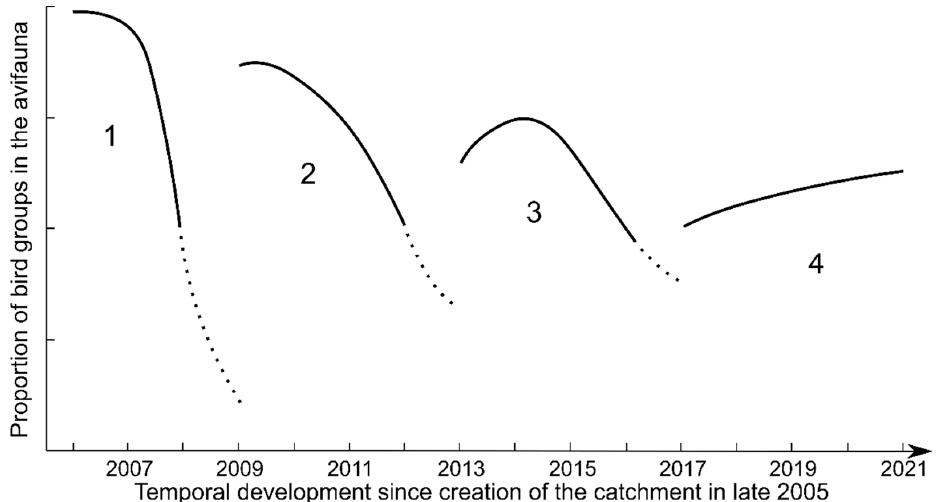
Figure 3. Schematic overview of the abundance of the four bird groups as they successively occurred in the Hühnerwasser catchment. The four stages are characterized in the text. The dominance of each bird group is likely to be lower than that of previous groups, because the 6 hectare catchment is undergoing a development towards increasing habitat heterogeneity.